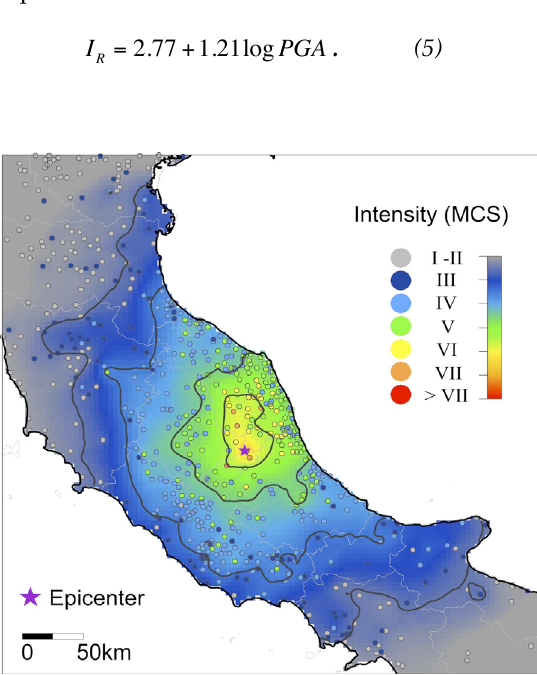
Figure 5. Municipality intensities (coloured dots) and the regional macroseismic field (I represent isoseismals separating intensity degrees.